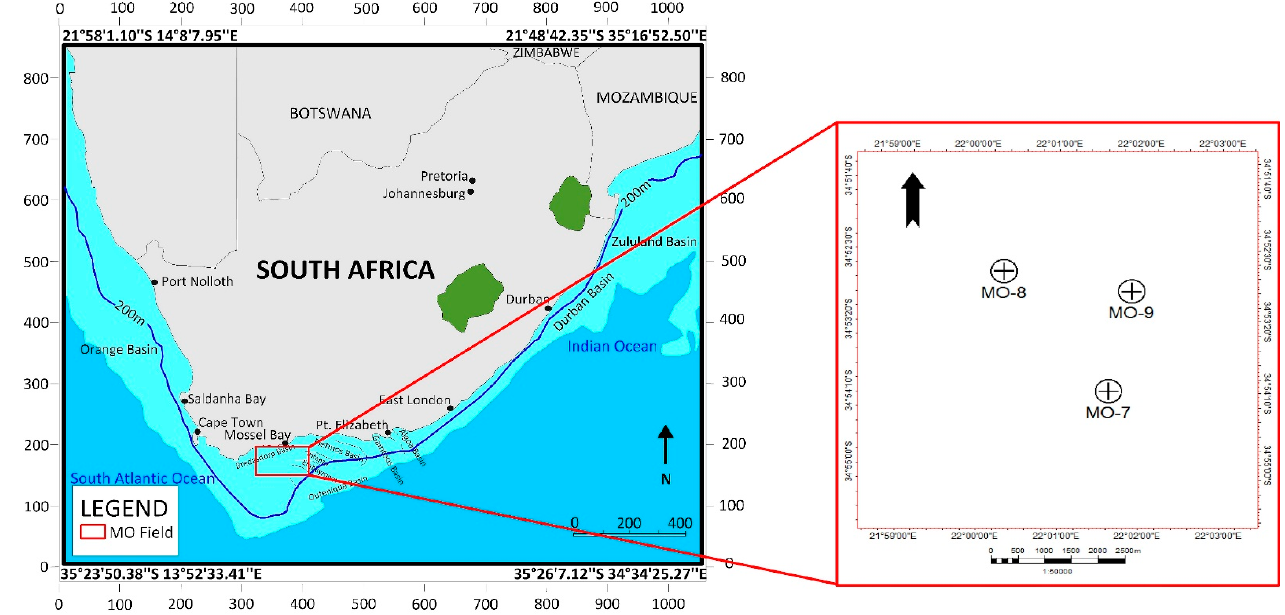
Figure 1. Maps showing the area of study offshore South Africa and the location of the wells.